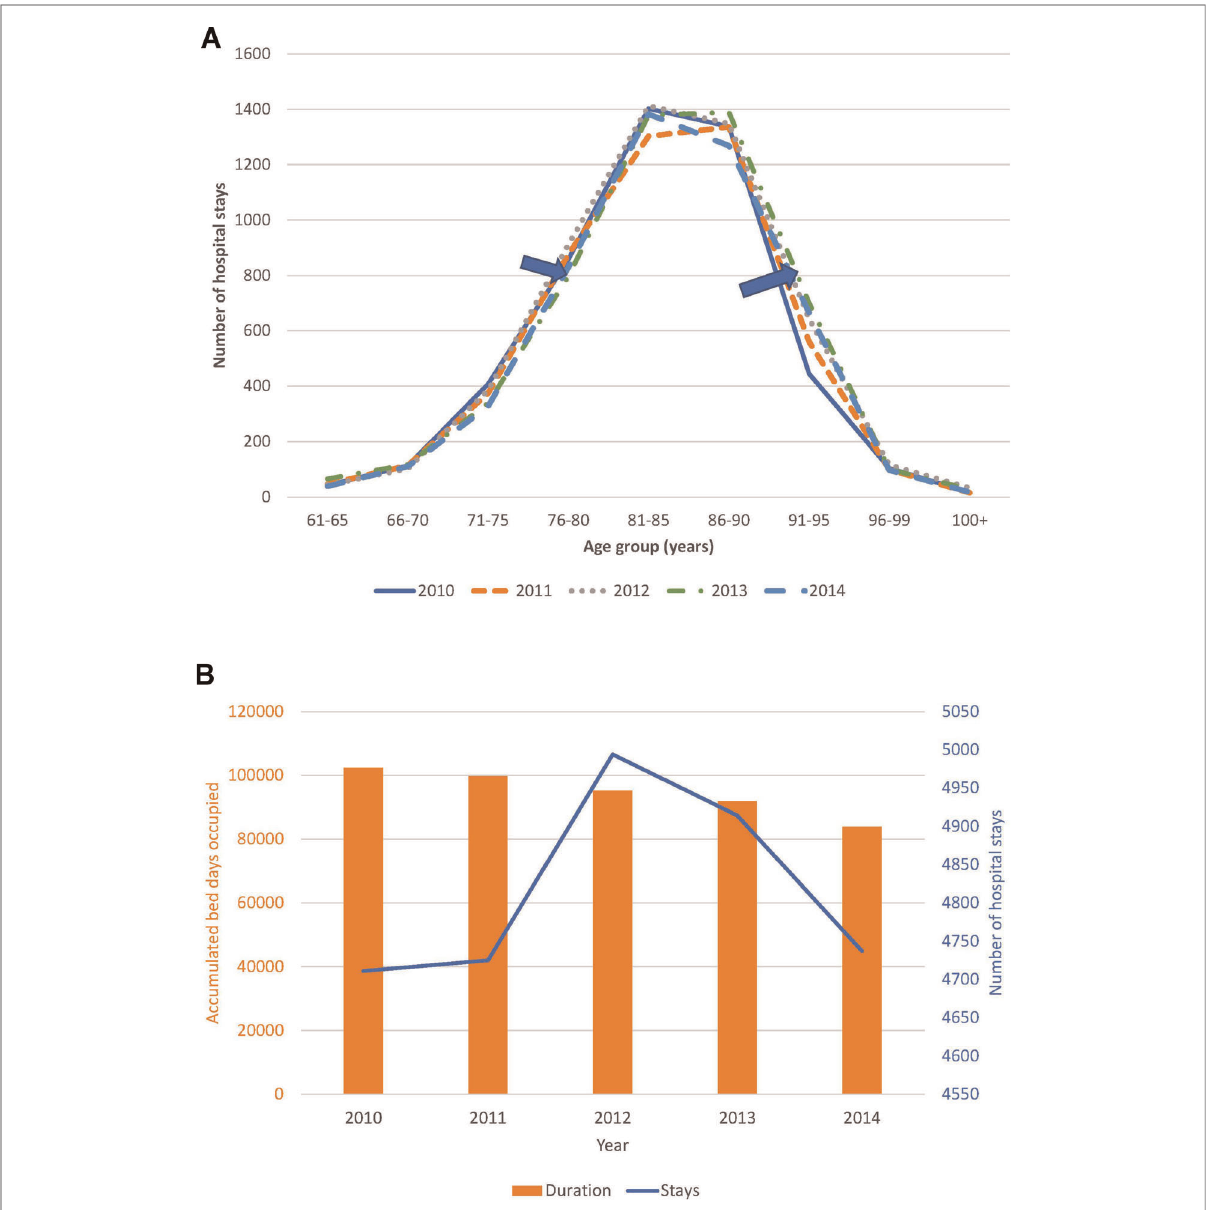
FIGURE 4 ( A ) Time trend in the age distribution per year for the geriatric ward. ( B ) Time trend for accumulated hospital bed-days (bars) with hospital stays (line) per year in the geriatric